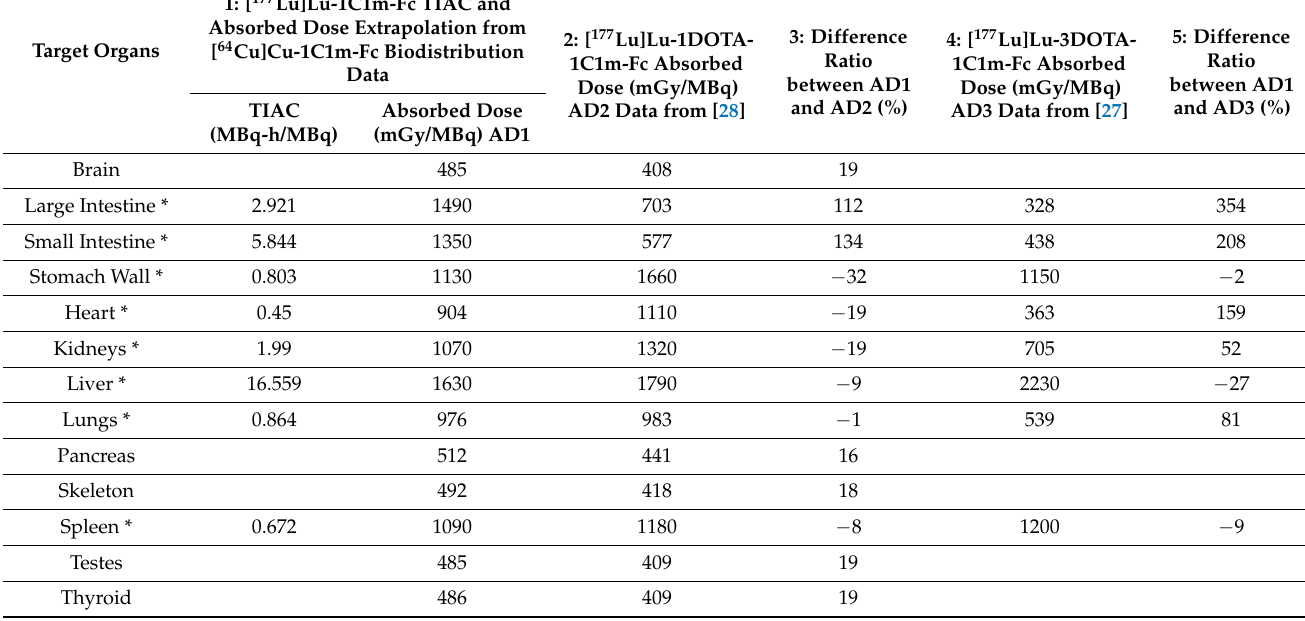
Table 4. 1: TIAC (only for source organs) and organ-absorbed doses for [ 177 Lu]Lu-1C1m-Fc extrapolated from experimental murine biodistribution data of [ 64 Cu]Cu-1C1m-Fc. Source organs are indicated with *. Absorbed dose estimates using the sphere model of